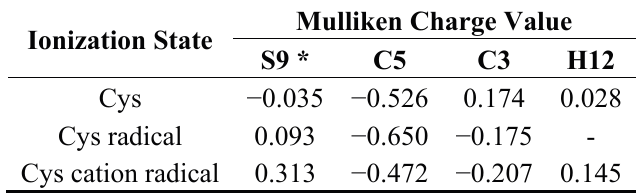
Table 7. The Mulliken charge distribution in Cys and corresponding radical and cation